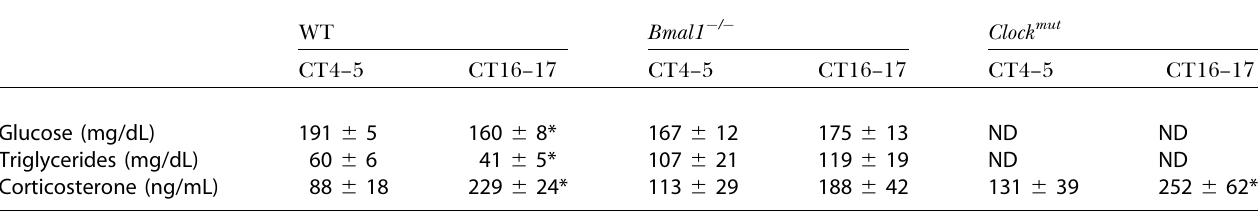
Table 1. Clock-Controlled Metabolic Rhythms WT Bmal1 (cid:1) / (cid:1)